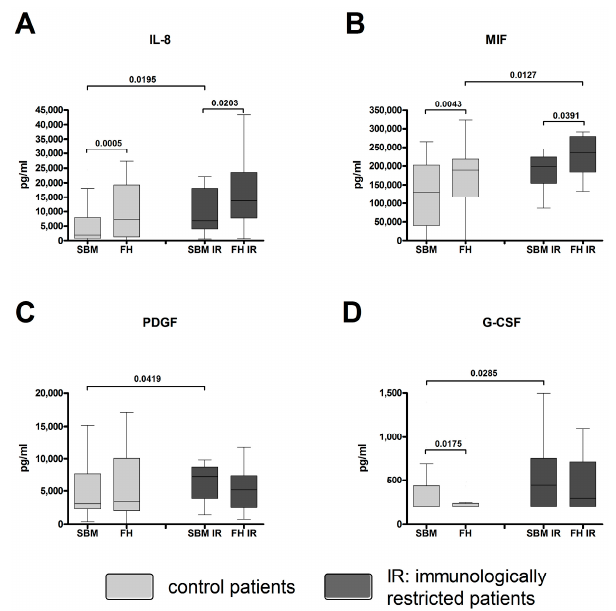
Figure 5. Angiogenic factors are highly secreted in FH/SBM of immunologically restricted patients. Supernatants from FH and SBM of immunologically restricted patients (FH IR/SBM IR: dark grey) and controls (FH/SBM: light grey) were analyzed for the concentrations of angiogenic factors via multiplex suspension array. ( A ) IL-8; ( B ) Macrophage migration inhibitory factor (MIF); ( C ) Platelet-derived growth factor (PDGF); ( D ) Granulocyte-colony stimulating factor (G-CSF). Controls n = 42, IR patients n = 20. IR-patients vs. controls Mann-Whitney U test, FH vs. corresponding SBM Wilcoxon test, p -values < 0.05 are shown as numbers in the Figure.